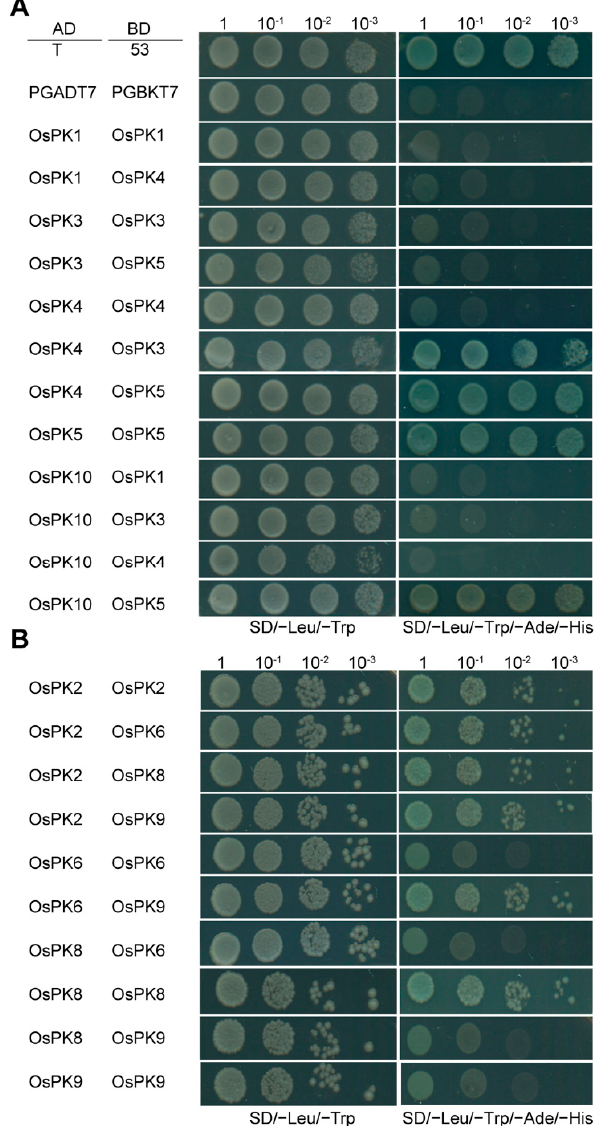
Figure 4. The interactions among PKs in rice. The Y2H assay was used to detect the interactions among the PK proteins and followed the concentration gradient of one tenth on the nonselective pressure medium (SD/ − Leu/ − Trp) and the selective medium (SD/ − Leu/ − Trp/ − Ade/ − His) for dot observation. ( A ) The interactions among PKc. ( B ) The interactions among PKp. The interaction between T (pGADT7-T) and 53 (pGBKT7-53) was used as a positive control. And pGADT7 and pGBKT7 were used as negative controls.